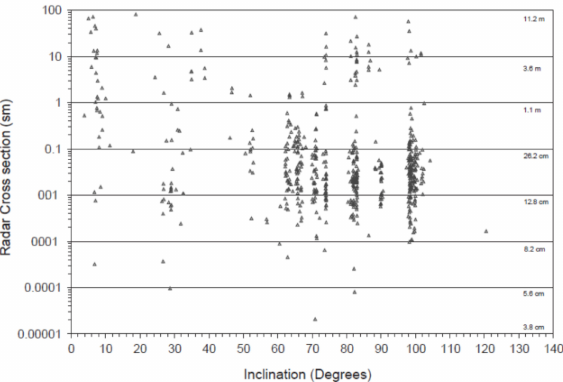
Figure 13. Distribution of the debris RCS vs. inclination of the uncatalogued objects detected by the AN/FPS-85 during May 2000 campaign [28]. Reprinted from Acta Astronautica, Copyright 2003, with permission from